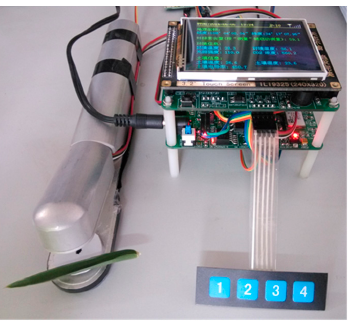
Figure 7. The experiment instrument of the farmland information collection device.